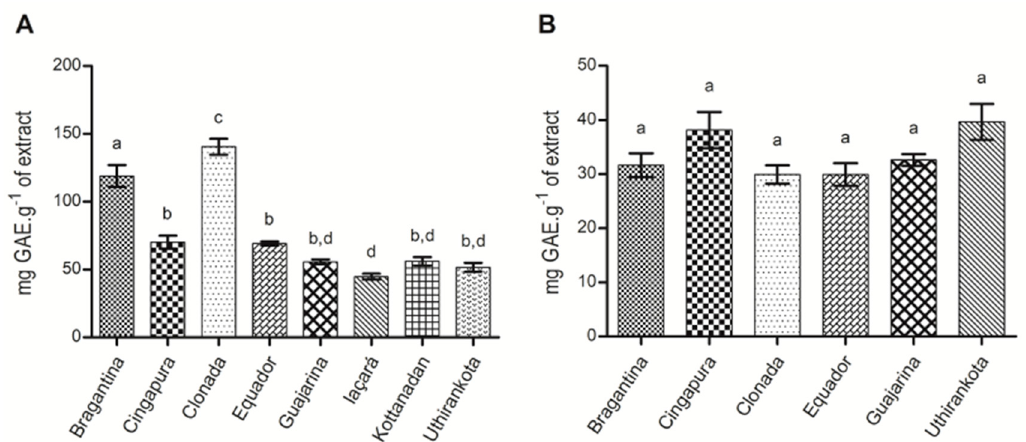
Figure 4. Total phenolic compounds produced in black pepper cultivars. ( A ) Leaves; ( B ) fruits. a–d Different letters represent a statistically significant difference by Tukey’s test ( p < 0.05).